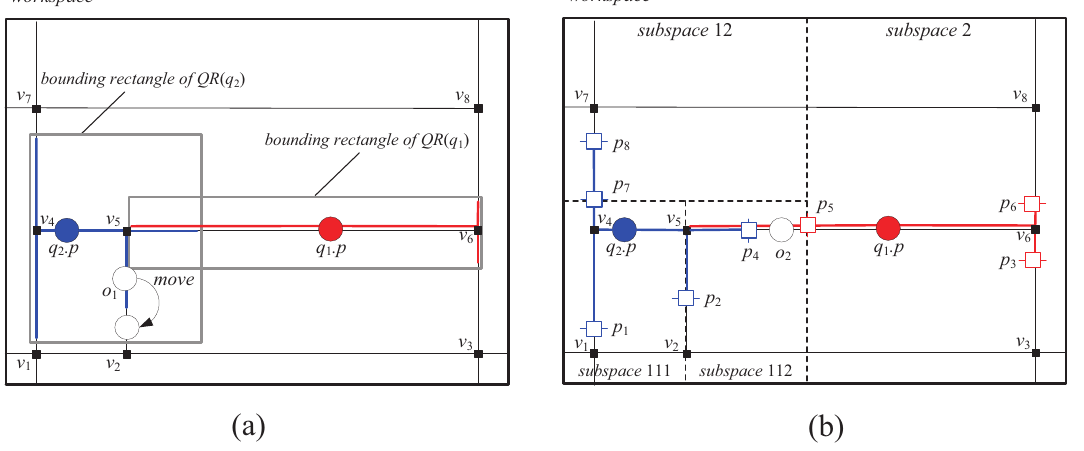
Figure 4. Examples of approximation of query ranges and the space partitioning approach used in this paper. ( a ) Approximation of query ranges; ( b ) The space partitioning approach used in this